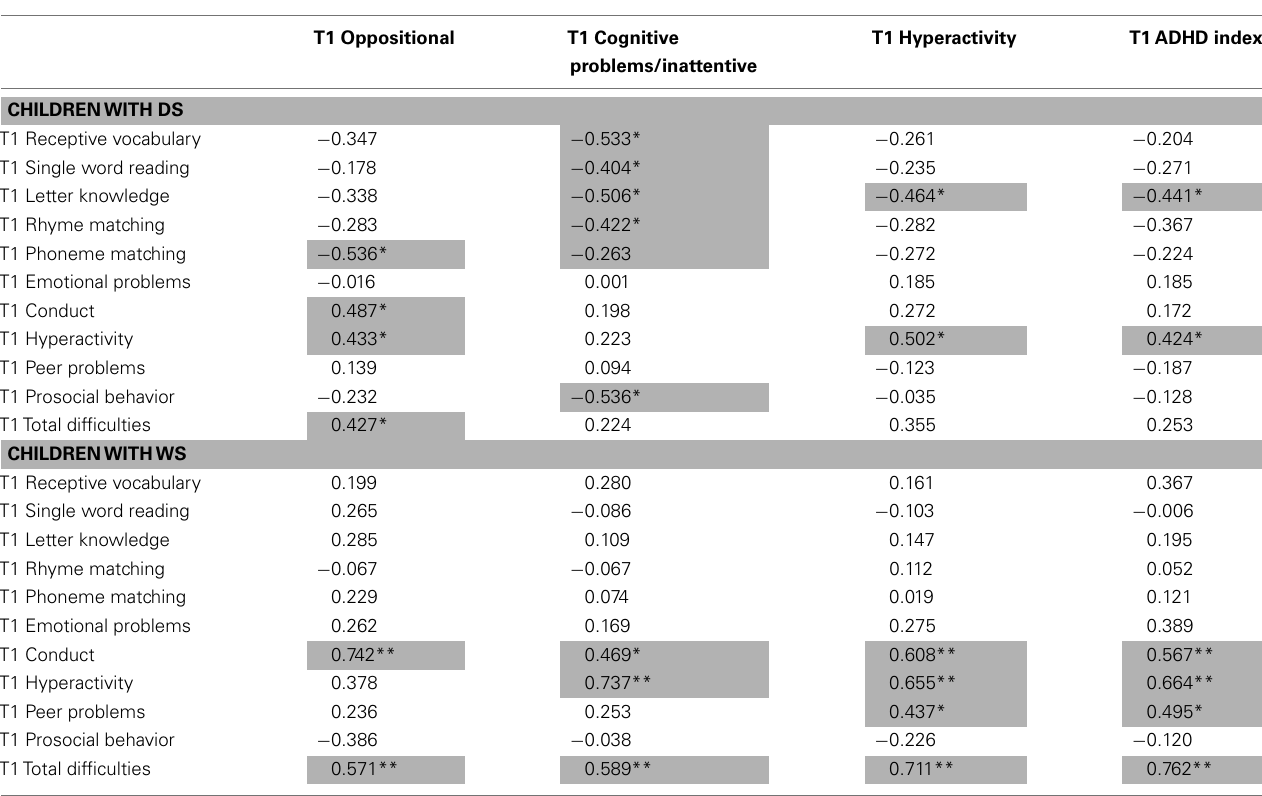
Table 4 | Pearson correlations atTime 1.